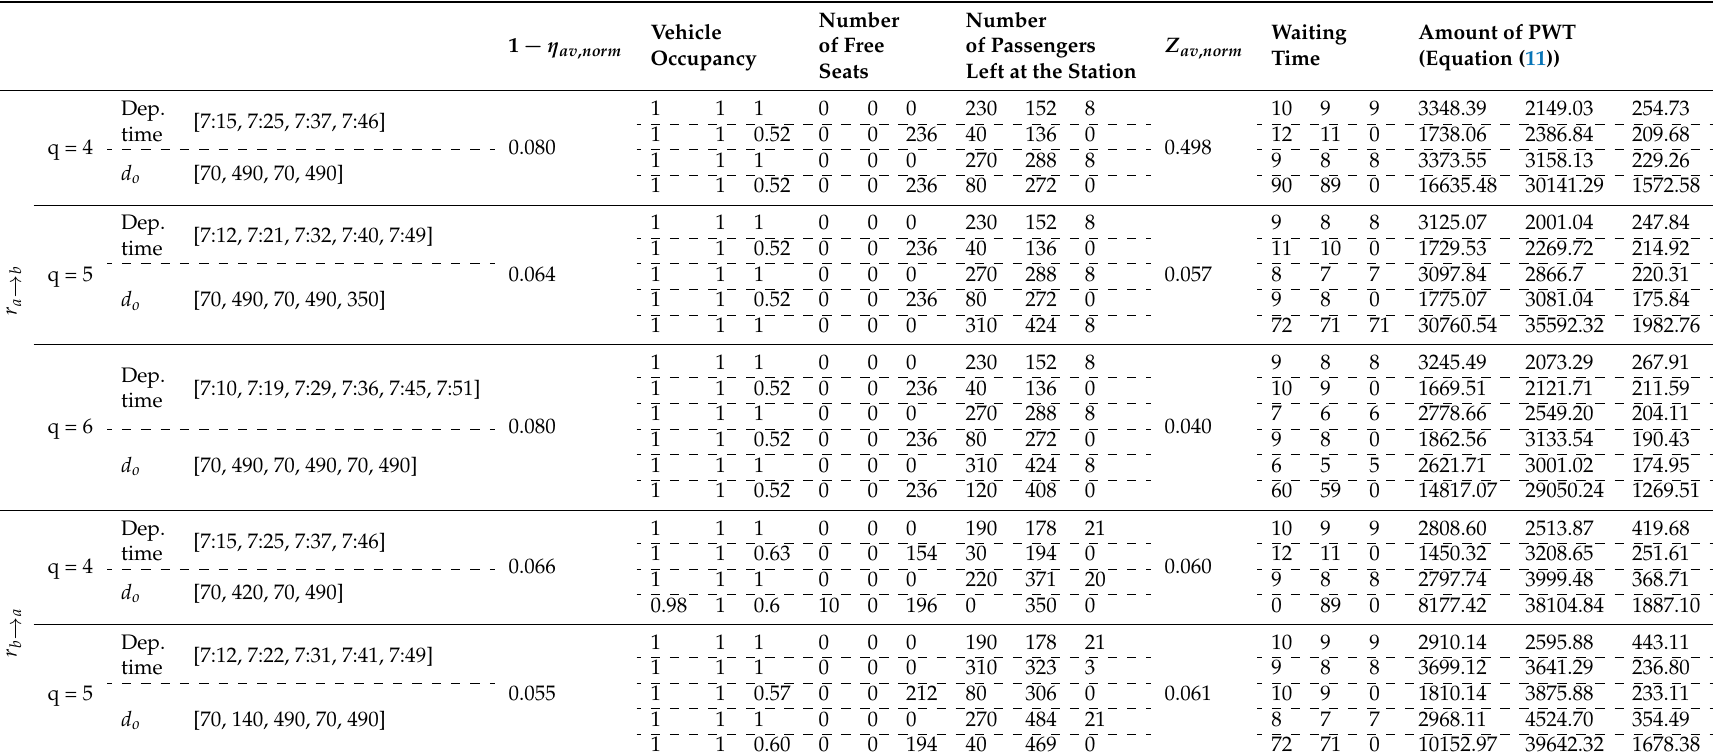
Table 5. Detailed results obtained in Experiment 2 using the proposed